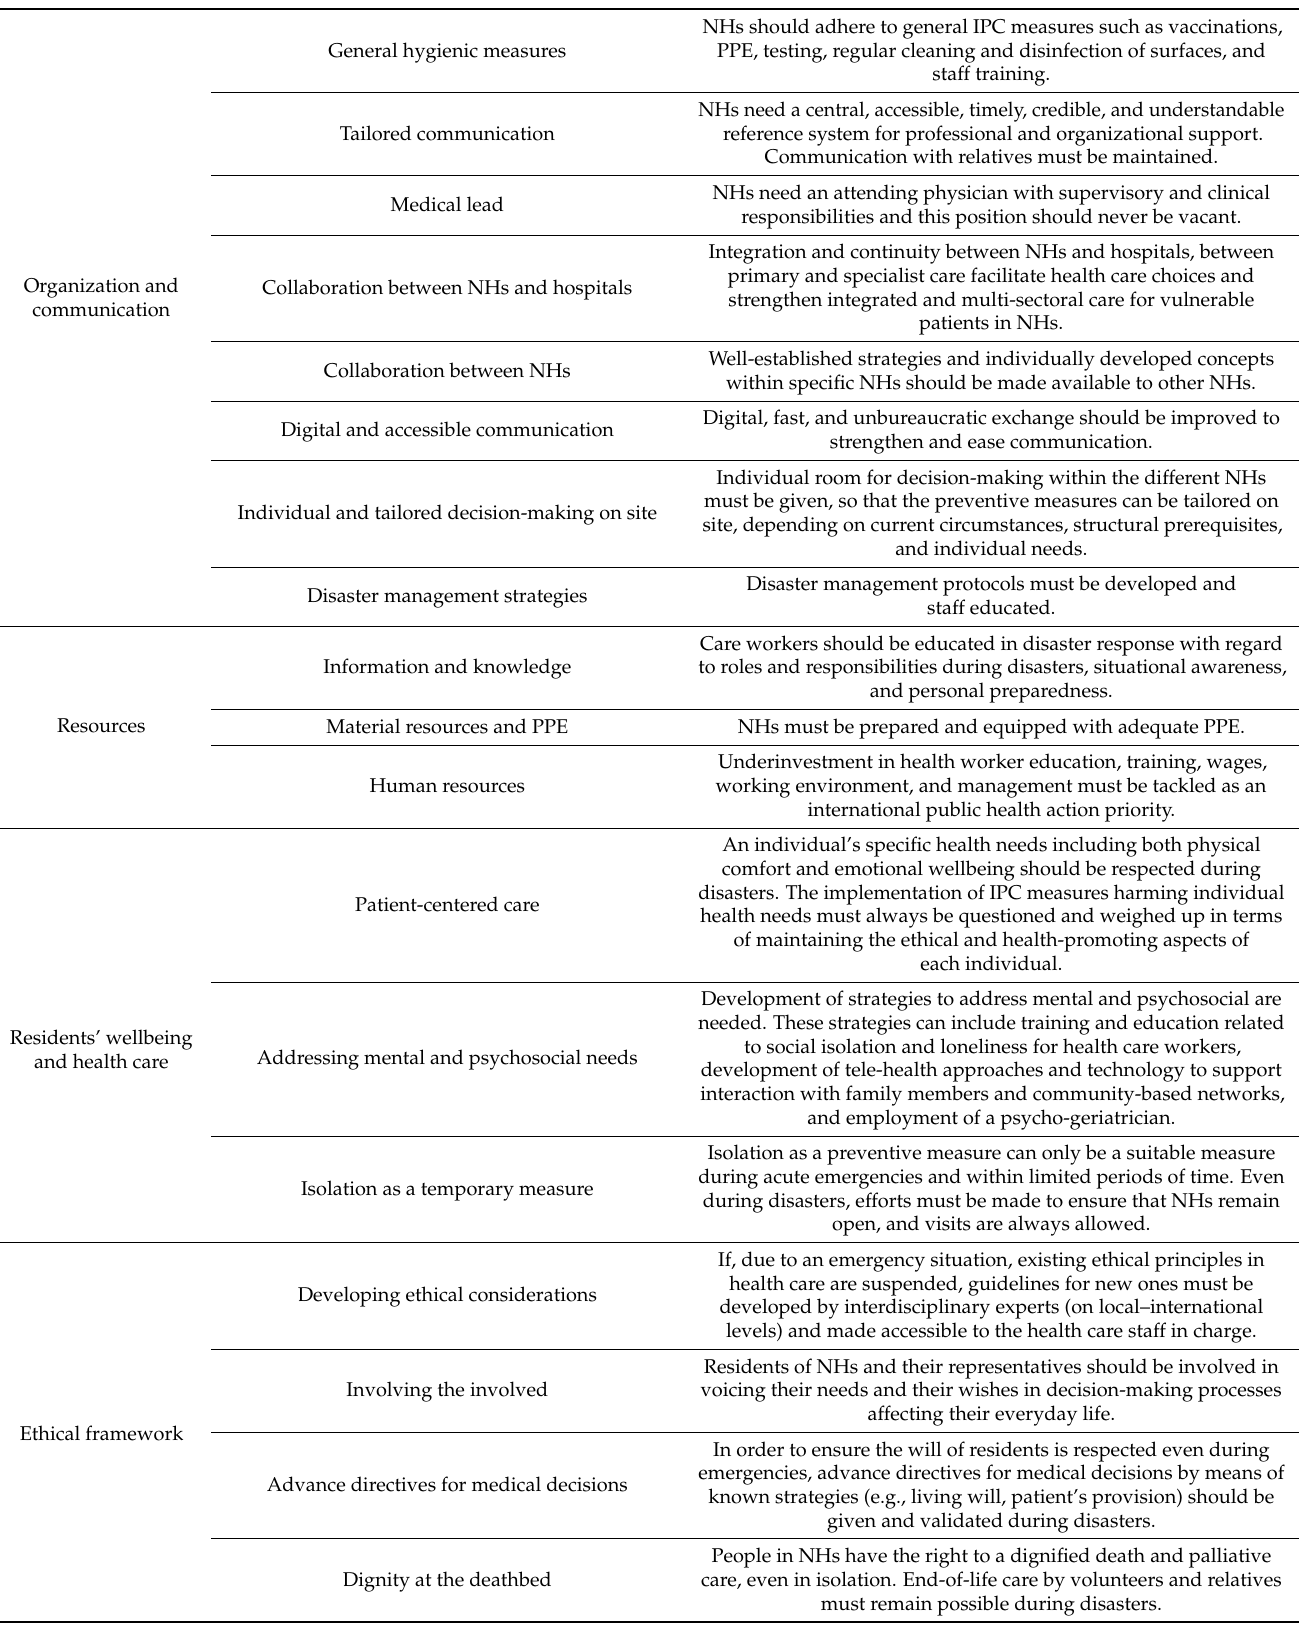
Table 4. Implications for disaster management strategies in